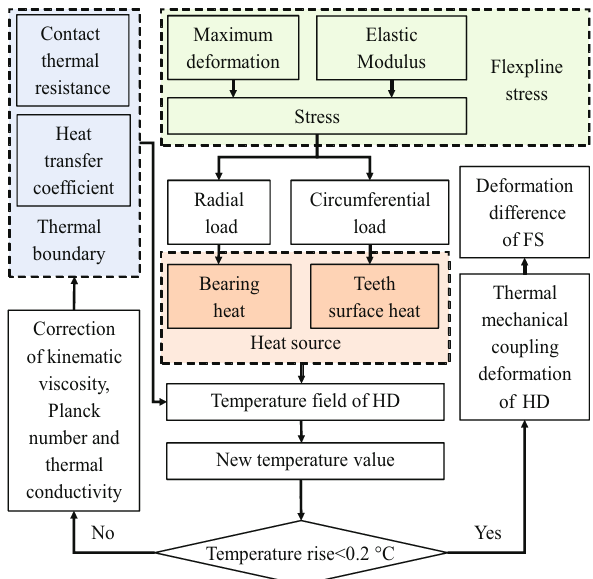
Figure 6: Technical route of thermal – mechanical coupling defor - mation analysis of